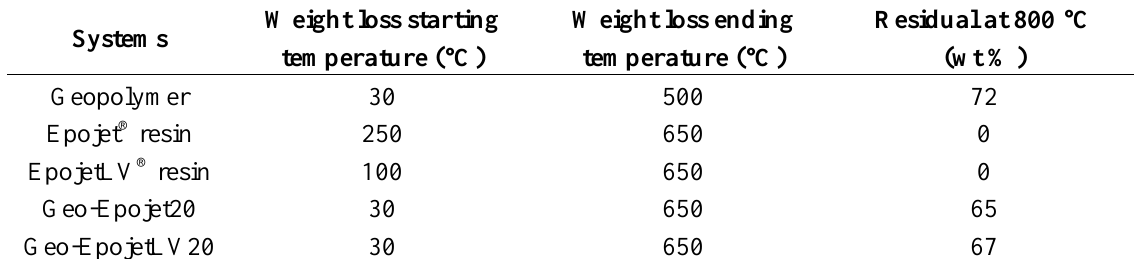
Table 1. Thermal properties of the neat geopolymer, pure epoxy resins, and hybrid composite specimens.